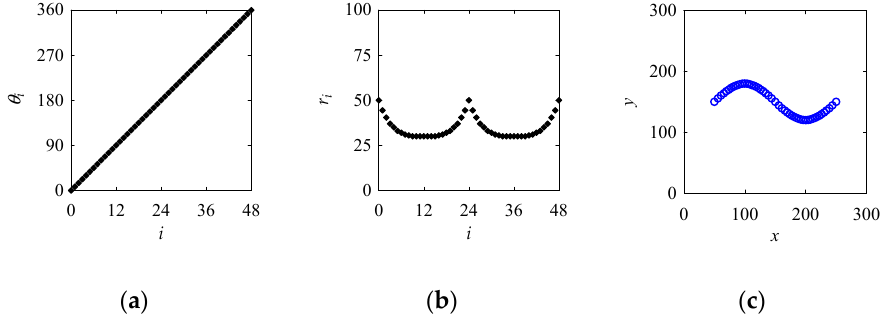
Figure 9. Settings for an S - shape using the PCA. ( a ) Input1: θ i ; ( b ) Input2: r i ; ( c ) Output: Point cloud of half of an S-shape.